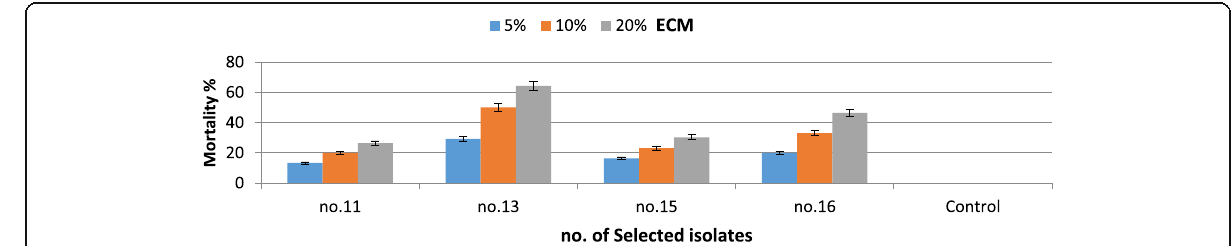
Fig. 1 Effect of different concentrations of ECM from the 4 selected isolates on mortality percentage of adults are represented as M ± SE, and statistical treatments were performed using ANOVA for differences comparing means in each concentration separately using Tukey ’ s HSD test. ANOVA parameters of 5, 10, and 20% concentrations, respectively were LSD = 1.628, 1.711, 1.509; P <